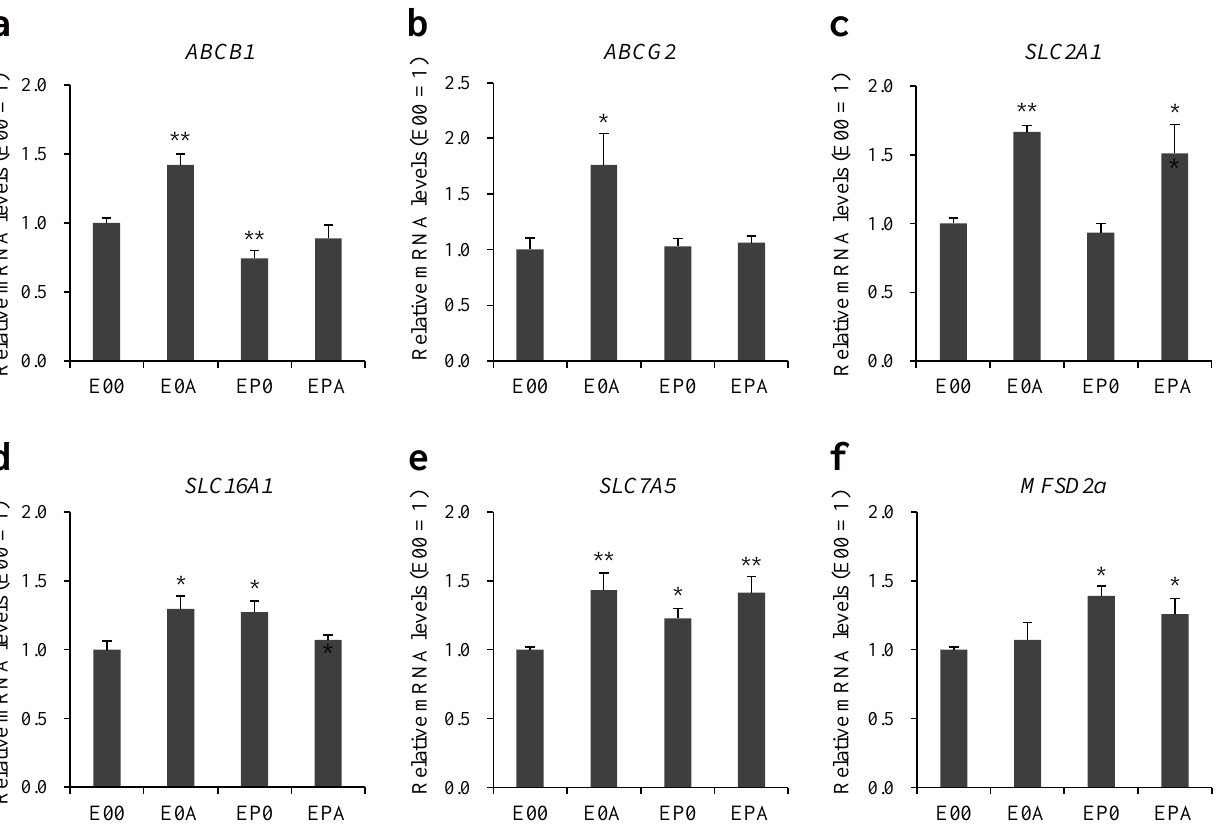
Figure 5. Expression of transporter genes ( a ) ABCB1; ( b ) ABCG2; ( c ) SLC2A1; ( d ) SLC16A1; ( e ) SLC7A5; and ( f ) MFSD2A in different BBB models. Expression of transporters were determined by quantitative PCR. All data are presented as means ± SEM (n = 4 − 9, * p < 0.05, ** p < 0.01 vs. E00).